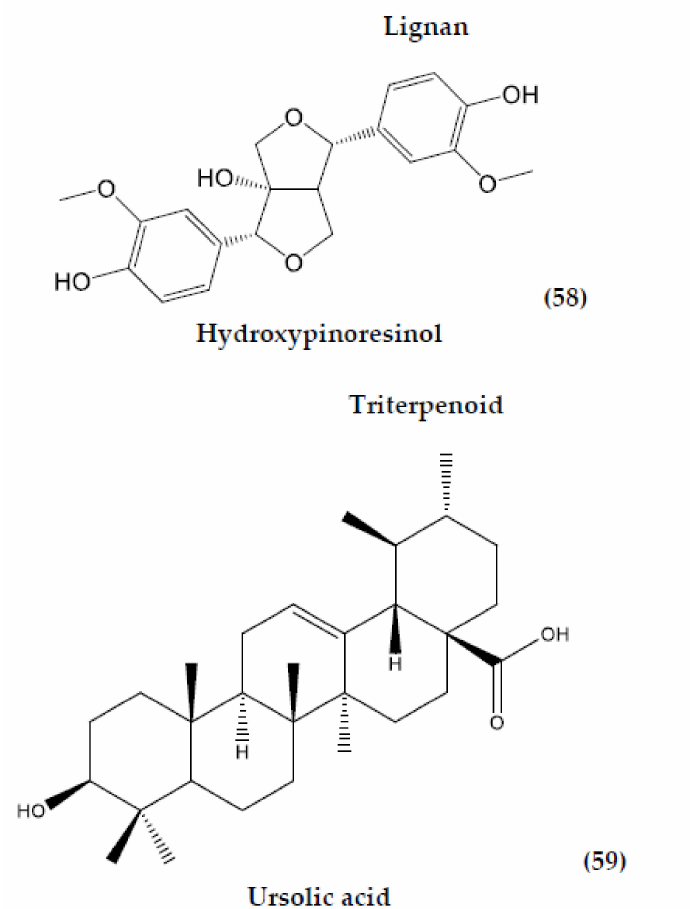
Figure 4. Structures of isolated phytochemicals in the genus Merremia